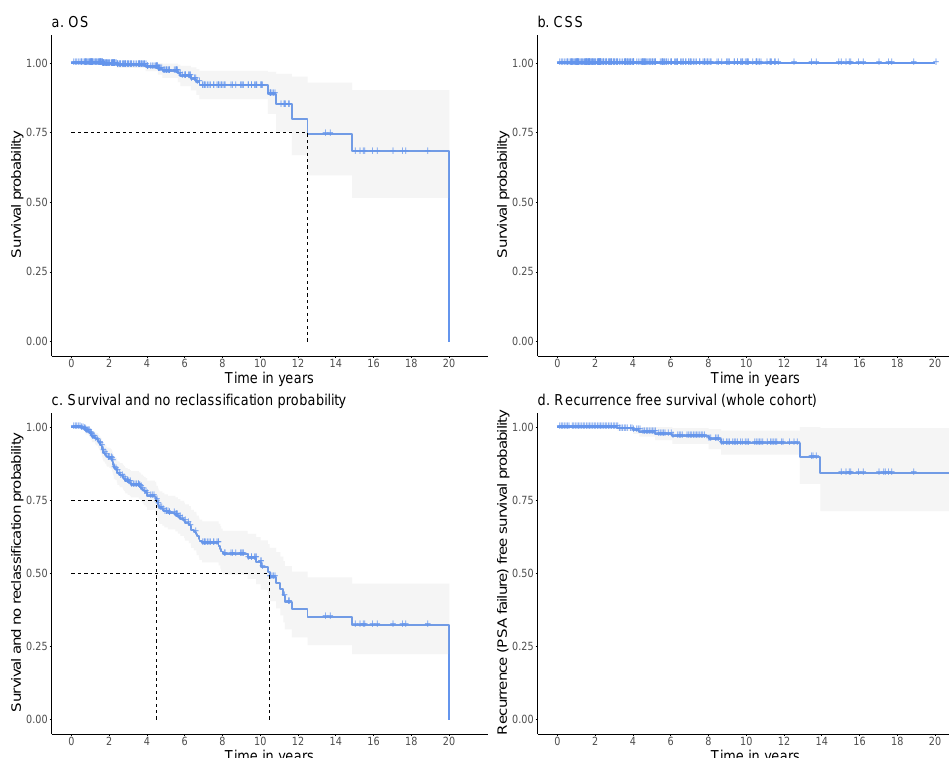
Figure 2. ( a ) OS at 92.3%, the dashed line shows the first quartile of 12.5 years; ( b ) CSS at 99.7%; ( c ) Survival and no reclassification probability, the dashed lines show the first quartile (4.5y) and median (10.5y); ( d ) Recurrence free survival rate at 89.8% (whole cohort). CI in light